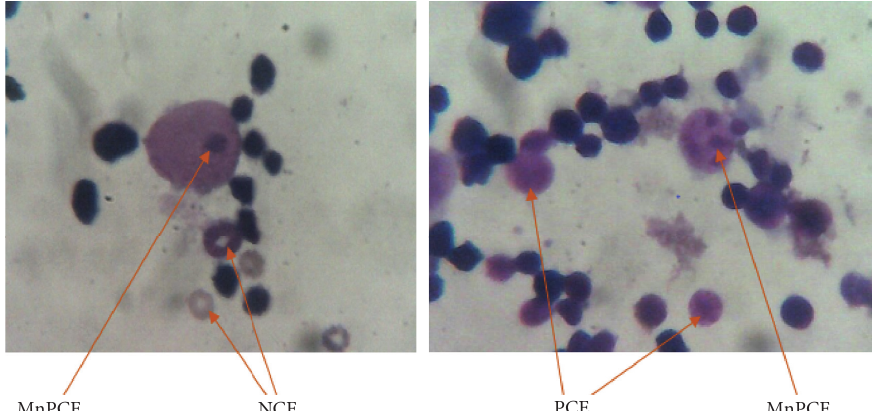
Figure 1: Representative images of micronucleus in polychromatic erythrocyte (MNPCE), polychromatic erythrocyte (PCE), and nor- mochromatic erythrocyte (NCE). The bone marrow slides were stained with May Gr¨unwald and Giemsa stain. Power oil immersion is 100 x